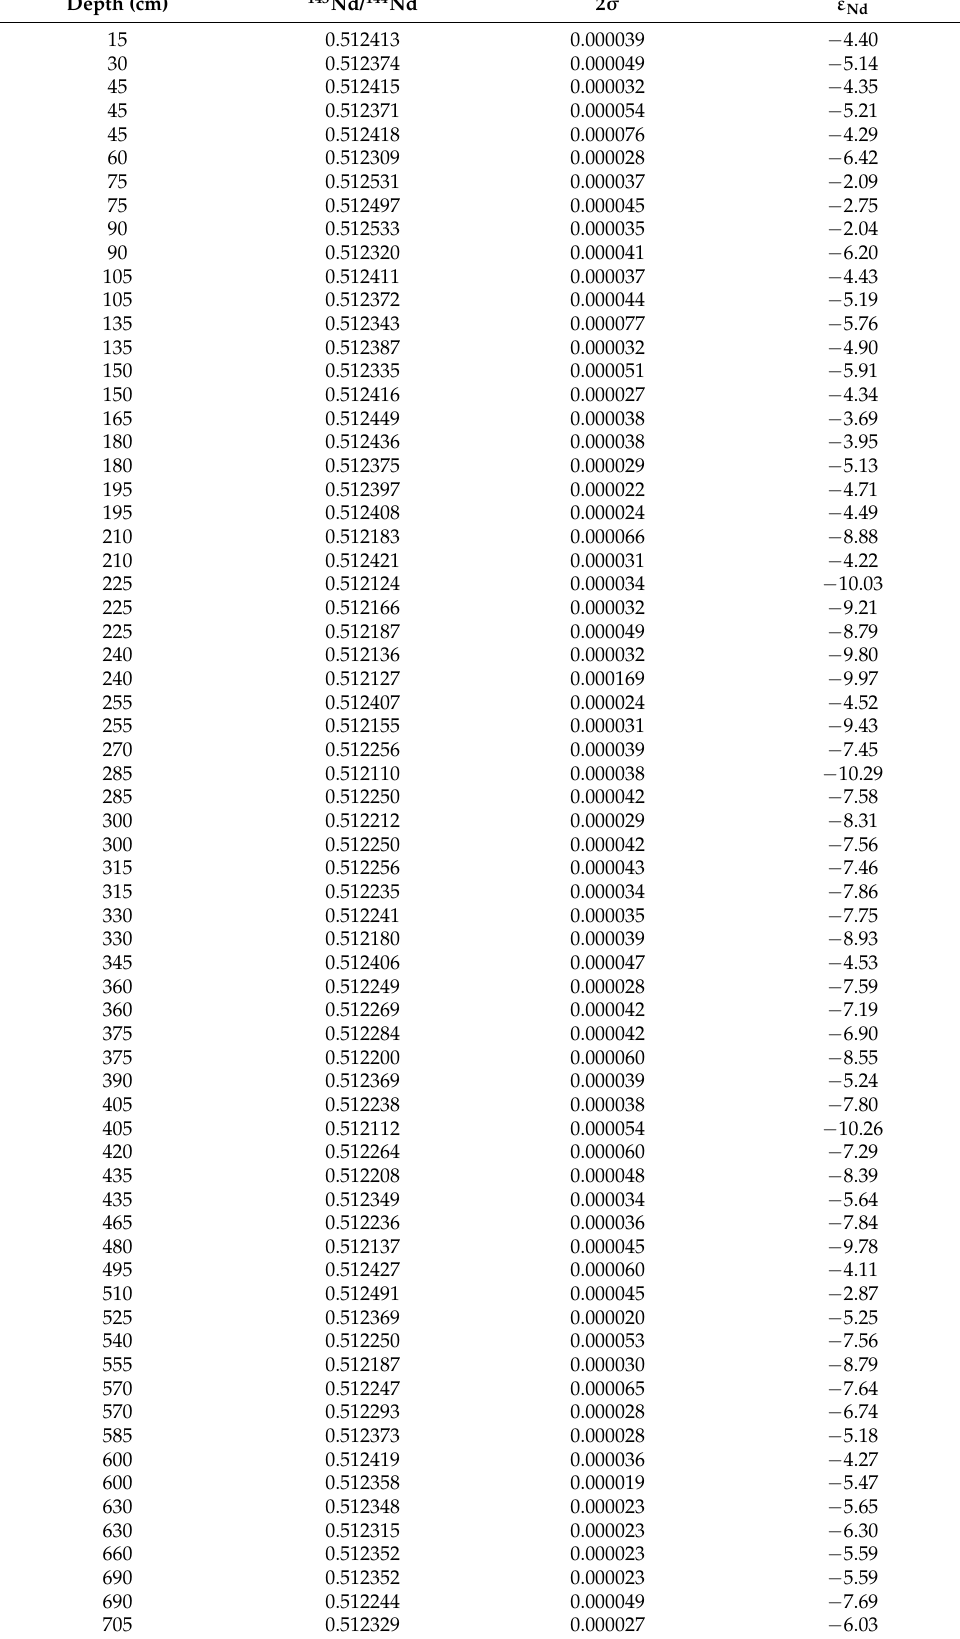
Table 3. Nd isotopic data for P10 fish teeth